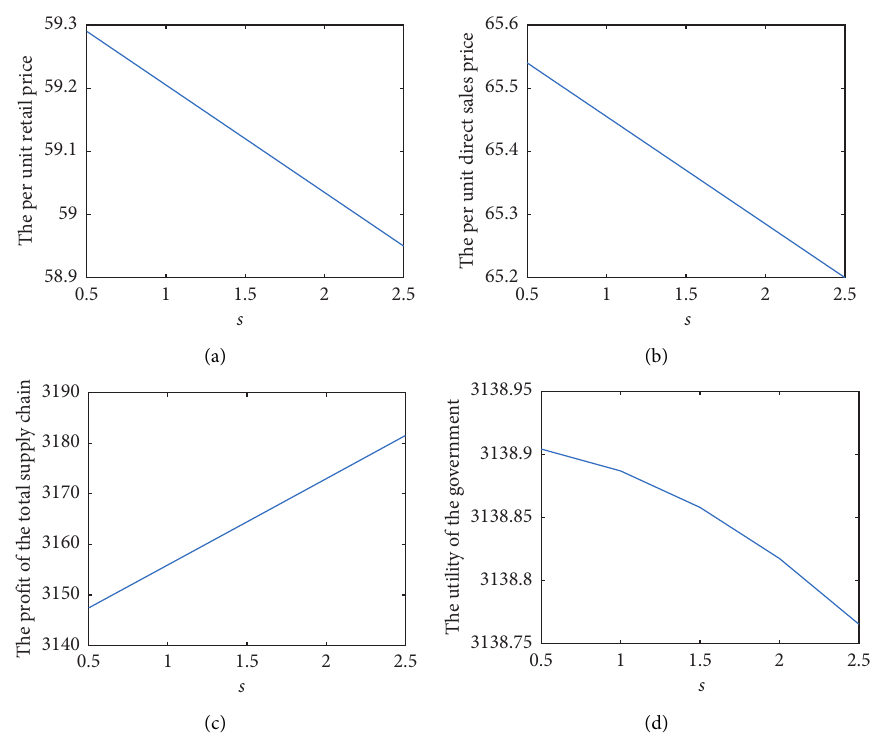
Figure 3: The effect of the government’s subsidy coefficient s based on centralized decision. Table 5: The effect of the degree of consumer preference for the retail channel ρ based on decentralized